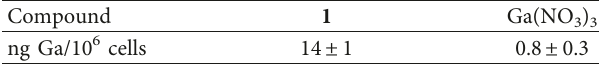
Data represent a mean ± SEM from two independent experiments, each made in